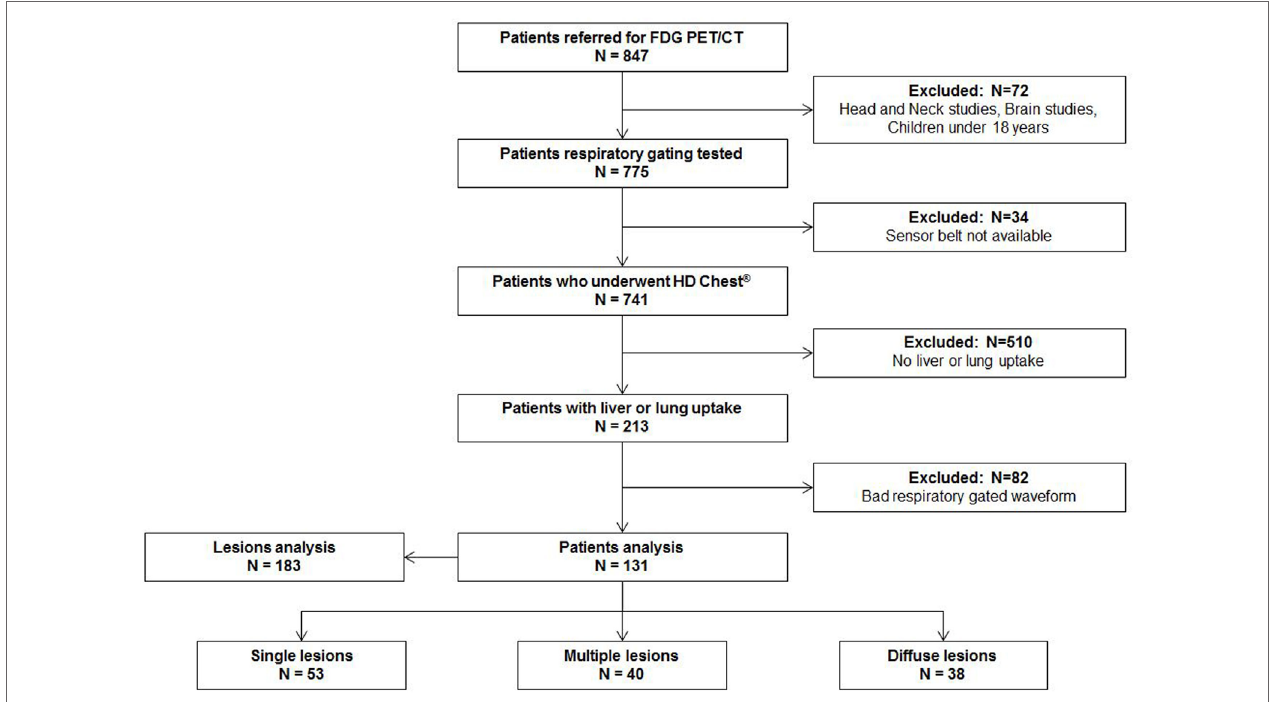
FigUre 1 | Study Flow Chart.